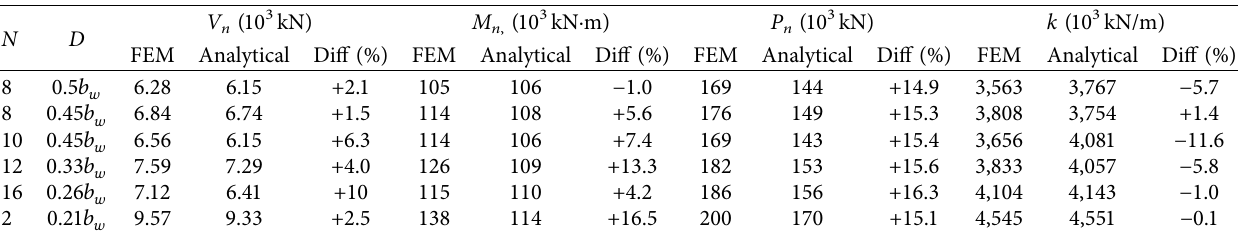
Table 8: Structural strengths obtained by the FEM and analytical